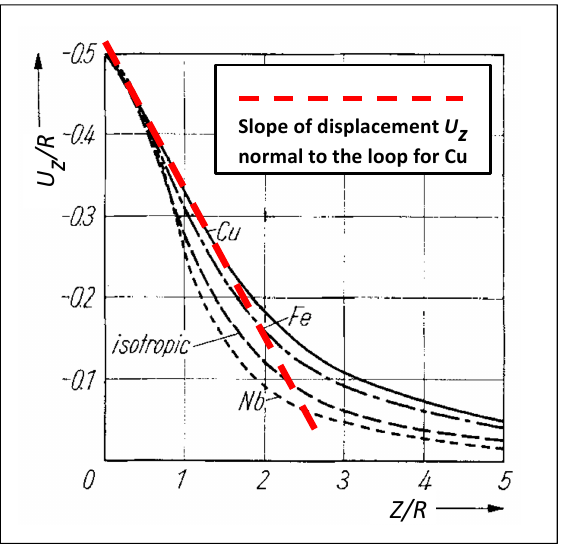
Figure 4. Dislocation loop displacements u z normal to the {111} loop plane at the center of the loop as a function of z for prismatic edge loops in cubic crystals. Adapted from Figure 5 in Reference [23] with permission.